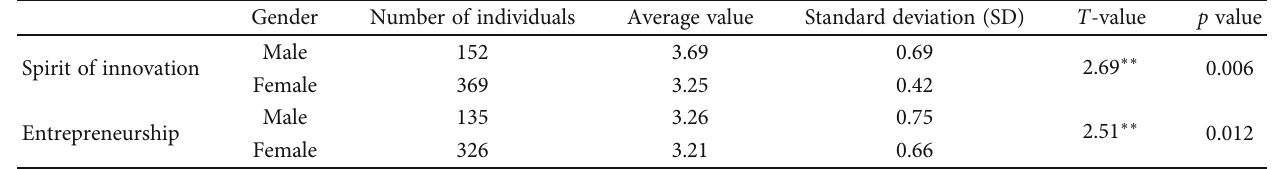
Table 1: Di ff erences in innovation and entrepreneurship by gender type.